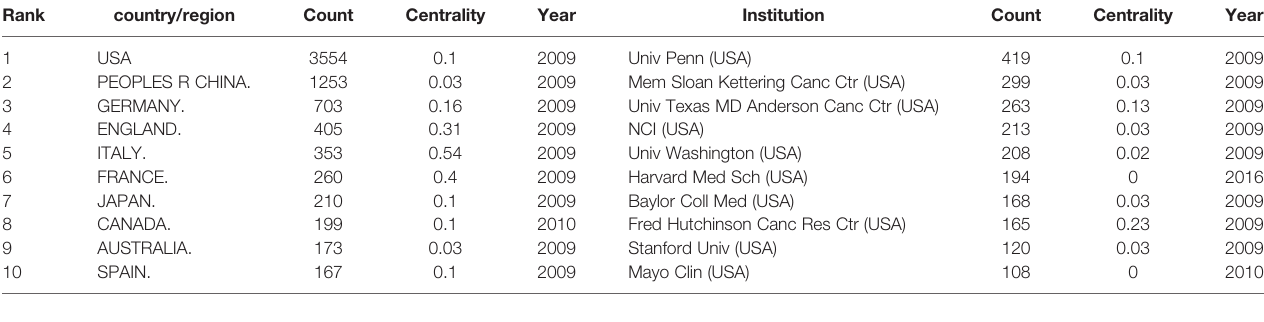
TABLE 1 | The top 10 countries/regions and institutions involved in CAR-T cells.